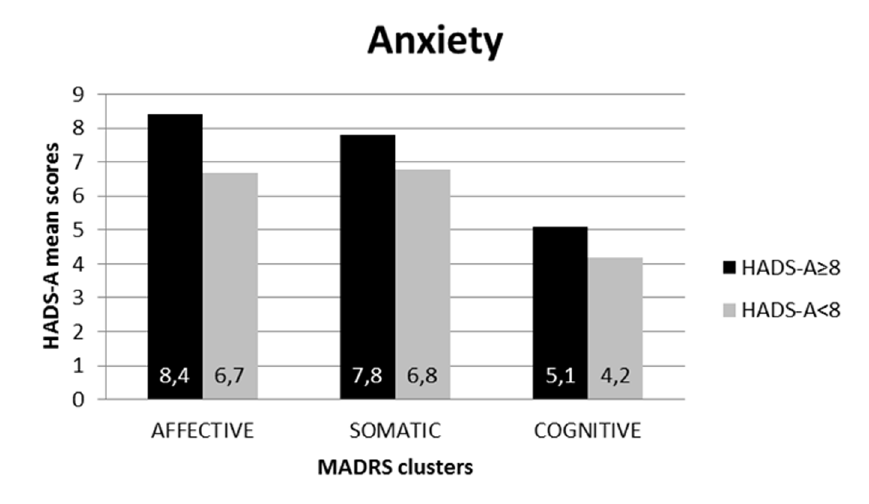
Figure 3. MADRS's clusters distribution according to HADS-anxiety cut-off.